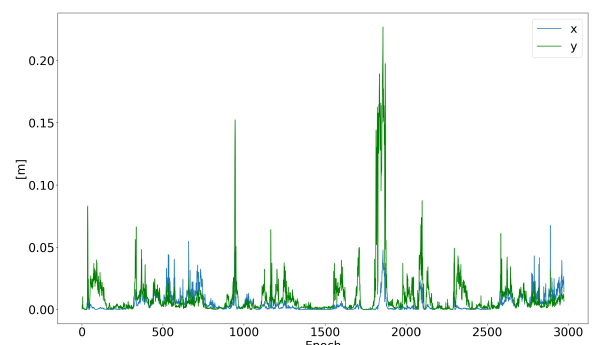
Figure 19. Variances along the x - (in blue) and y -axes (in green) over all epochs of the